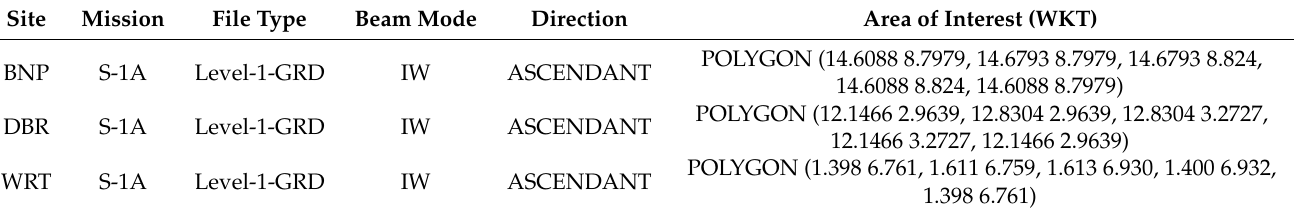
Table 1. Search options.